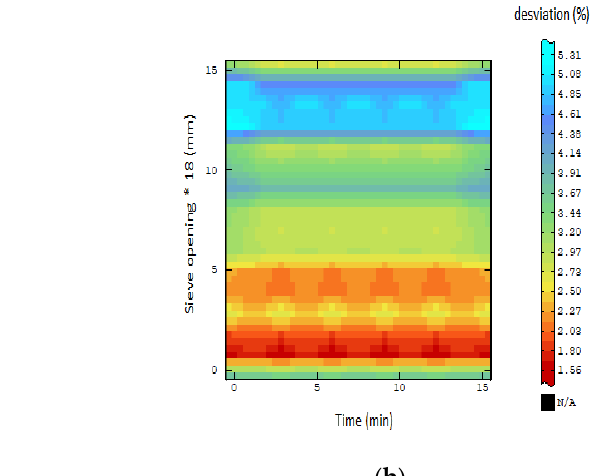
Figure 9. Spatial evolution of the standard deviation of the reconstructed data: ( A ) LGP-1 for ore-A; ( B ) LGP-2 for ore-B.